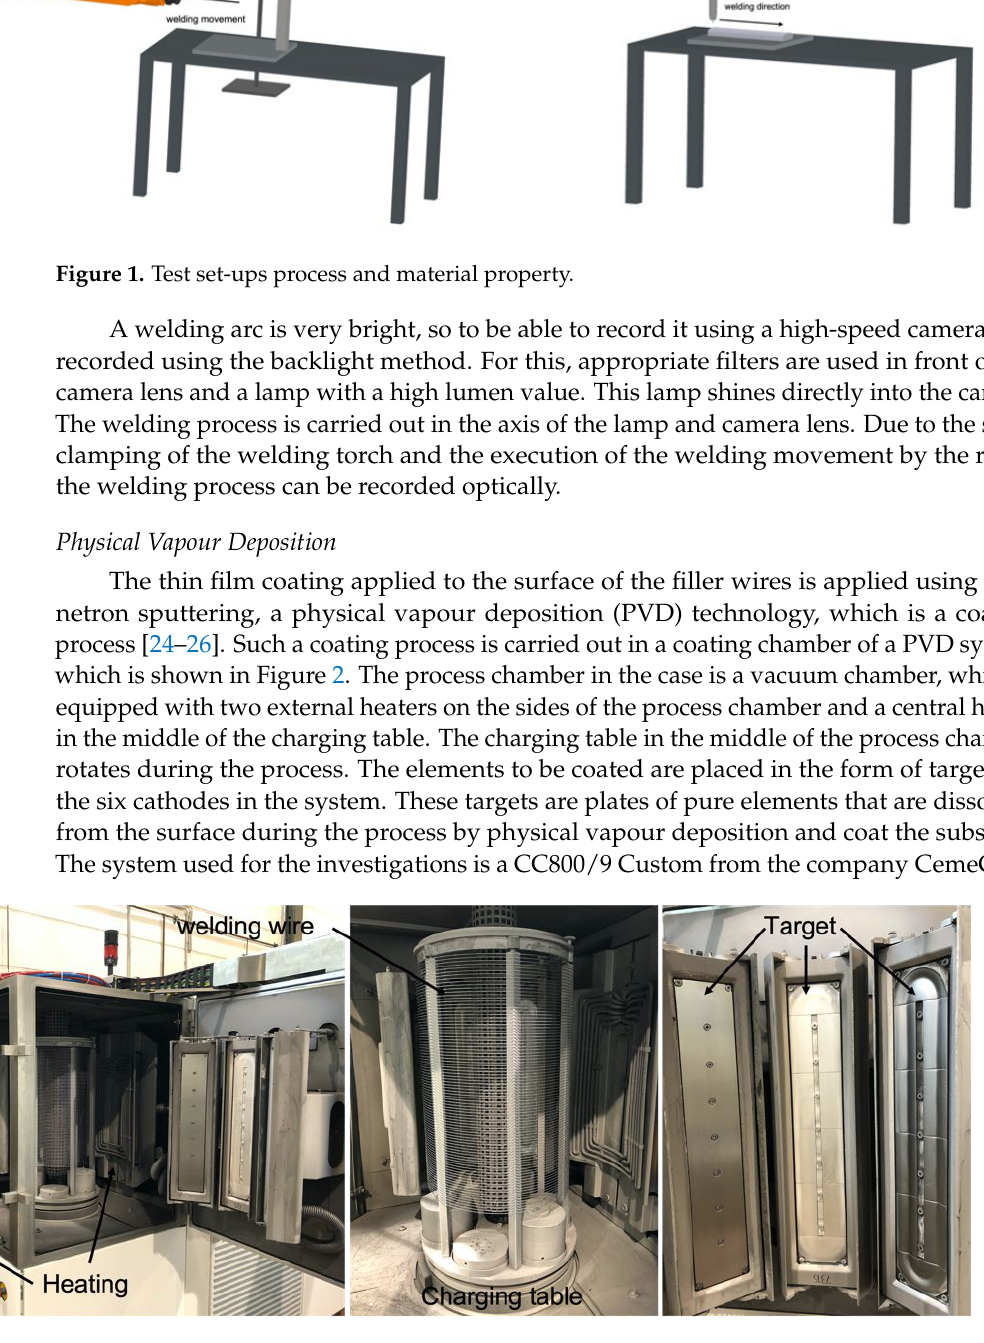
Figure 1. Test set-ups process and material property.